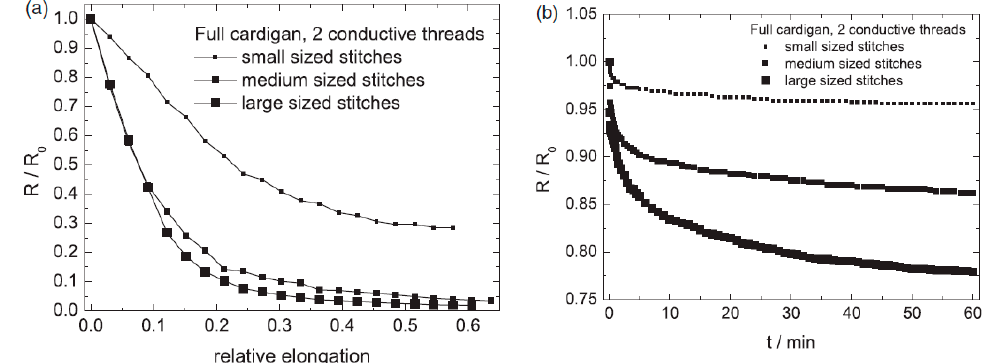
Figure 11. Effect of stitch size on electromechanical behaviour of full cardigan fabrics. ( a ) With respect to strain and ( b ) with respect to time [62] .